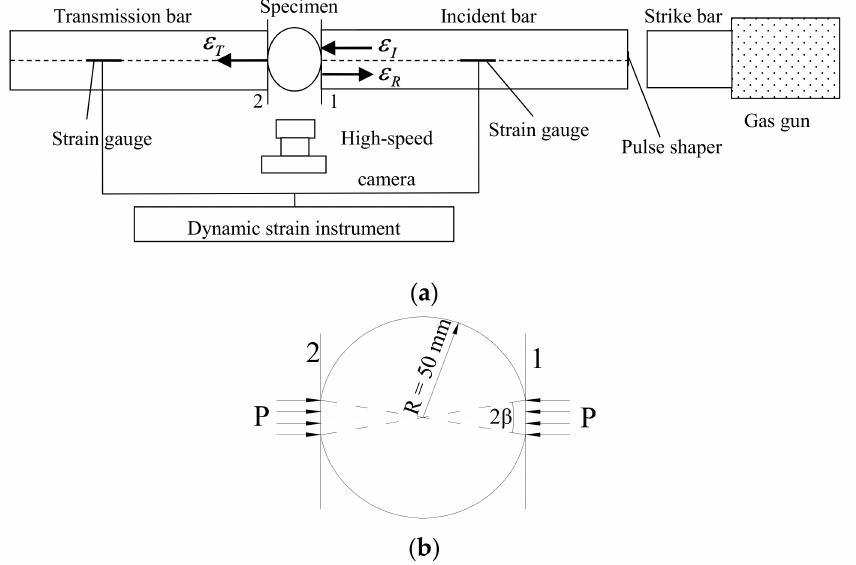
Figure 2. Split Hopkinson pressure bar (SHPB) arrangement used for the Brazilian tests. ( a ) Schematic of Split Hopkinson pressure bar (SHPB) test; ( b ) force deformation of the